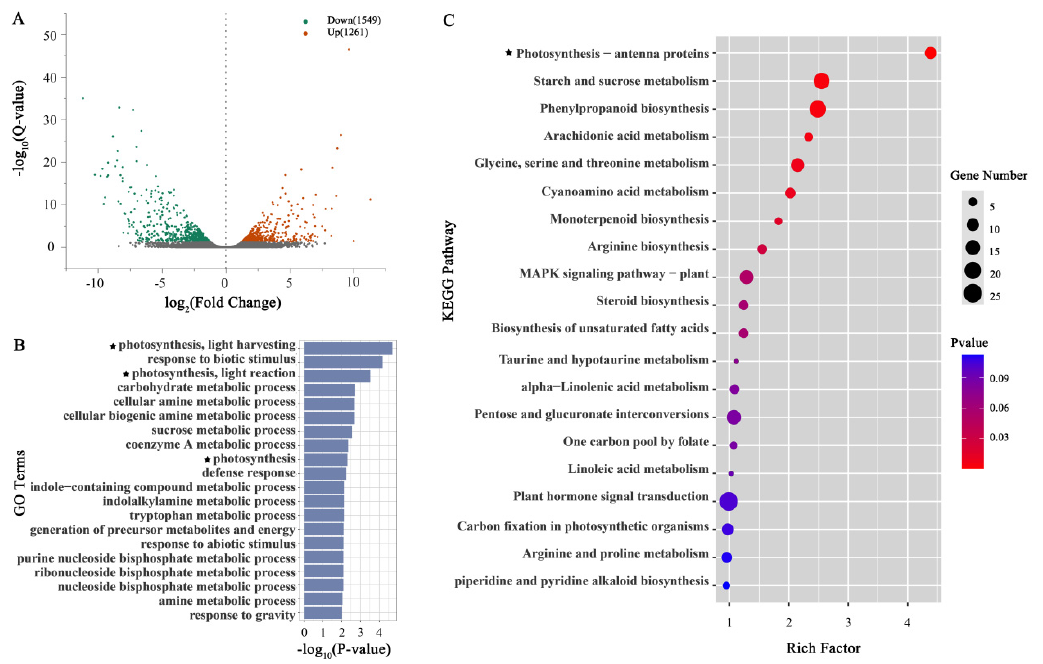
Figure 4. Screening and enrichment analysis of DEGs between wt and ym . A. Volcano plot of DEGs. grey dots: genes with no significant difference; red dots: significantly up-regulated genes; green dots: significantly down-regulated genes. B. Top 20 terms of GO enrichment analysis of DEGs. The GO analysis classifified the genes with corrected p -values of less than 0.05 into DEGs. C. Top 20 pathways of KEGG analysis of DEGs.The KEGG analysis classifified the genes with corrected p -values of less than 0.05 into DEGs. The five-pointed star represents photosynthesis-related items or pathways.